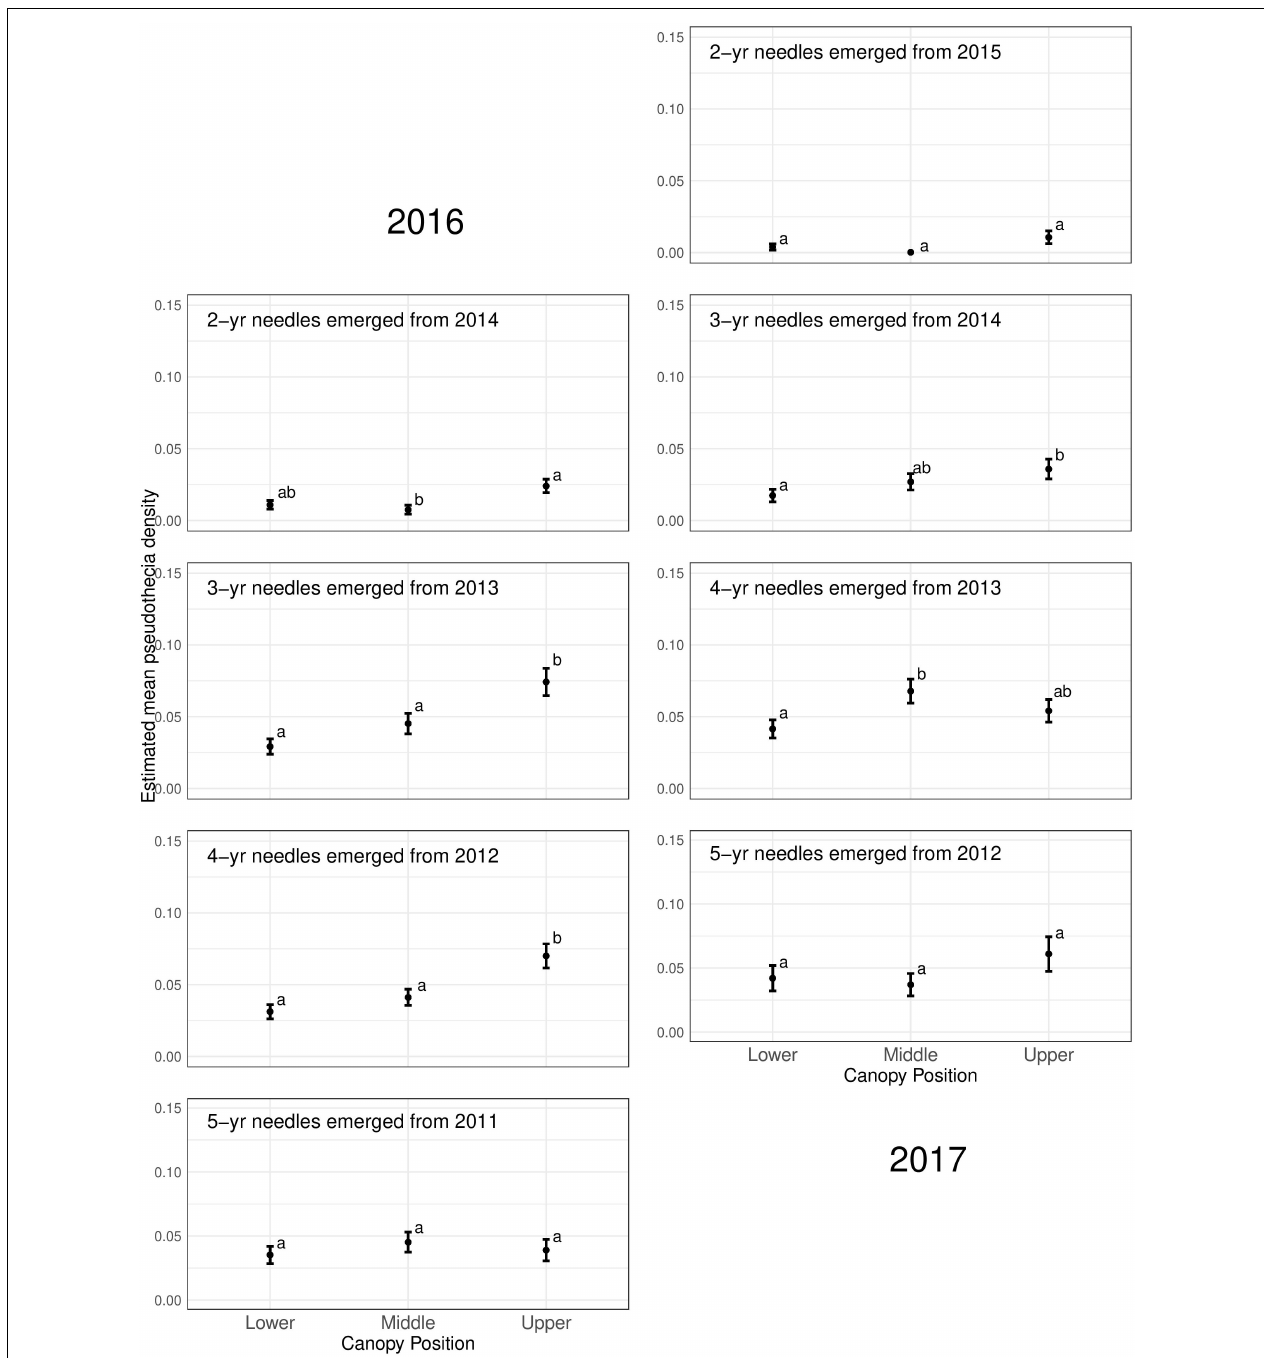
FIGURE 6 | Pseudothecia density by canopy position for 2- to 5-year old needles in 2016 and 2017 from mature Douglas-fir trees in western Oregon. Different letters represent that the two groups are statistically